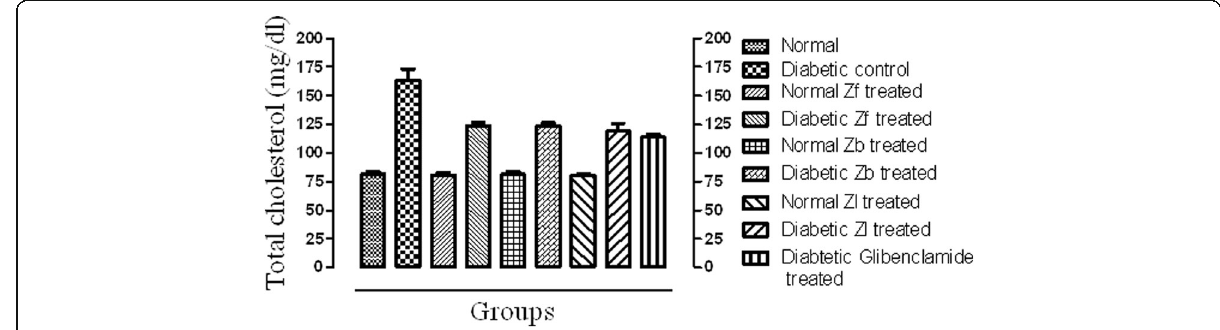
Fig. 1 Effect of extracts and standard drug on total cholesterol (mg/dl) level of normal and alloxan monohydrate induced diabetic